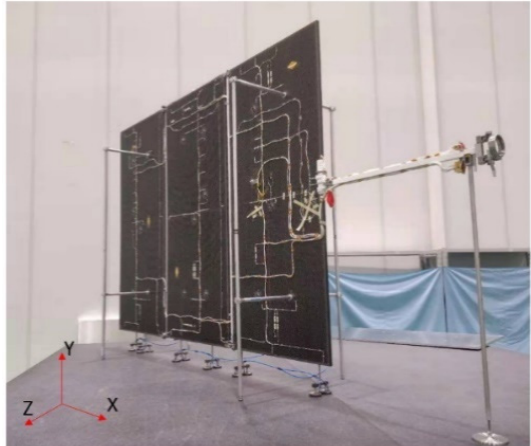
Figure 4. Solar array of a satellite.